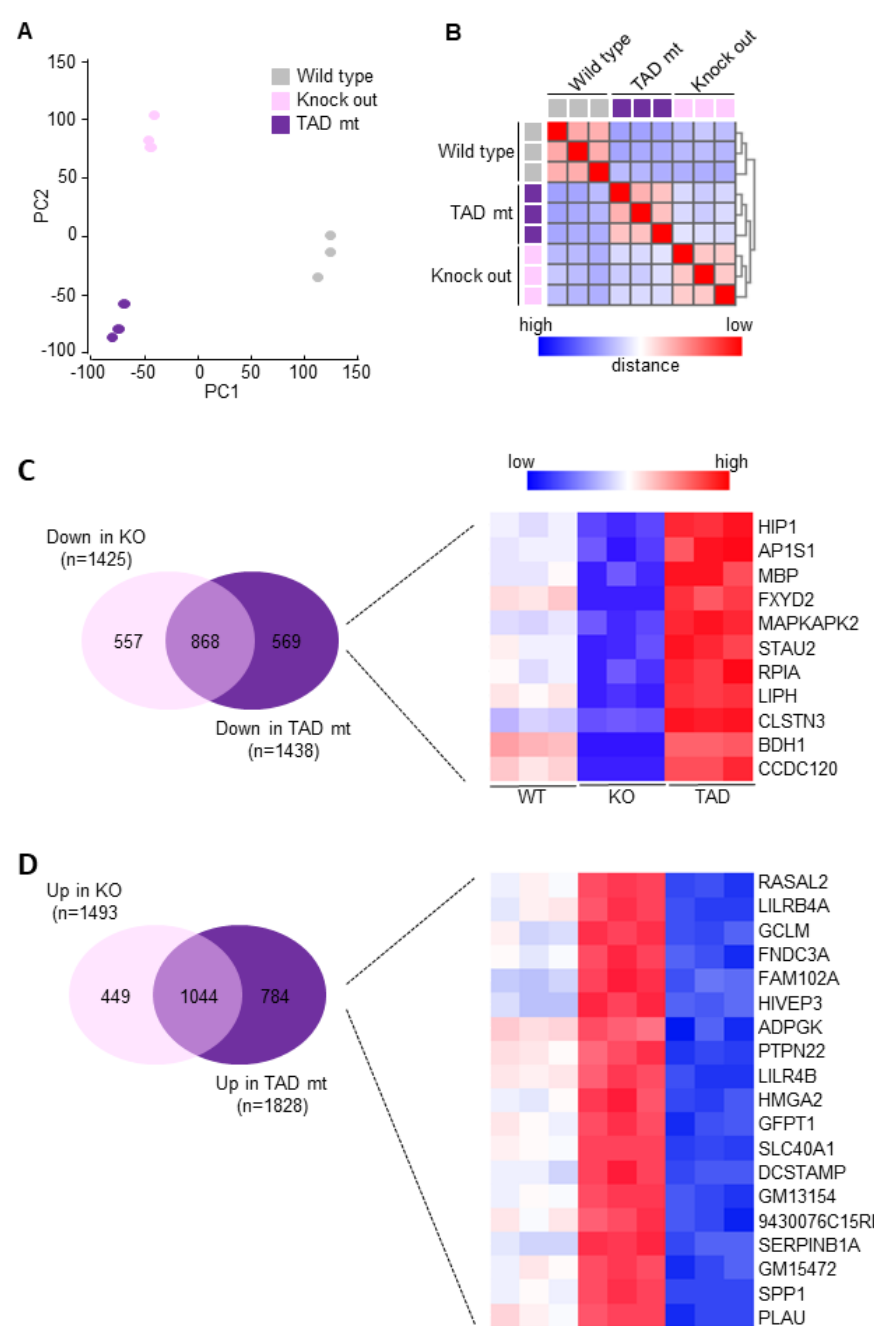
Figure 4. RNAseq gene expression analysis of wild-type (WT), C/EBP δ knock-out (KO) and C/EBP δ mutant ( ∆ TAD) macrophages. ( A ) Principal component analysis of pairwise genetic distances be- tween the different macrophage subtypes. ( B ) Correlation heat map showing the Euclidean distances between the different macrophage subtypes. ( C ) Venn diagram showing overlap in downregulation of genes in knock-out and ∆ TAD macrophages with a heatmap of genes downregulated in knock- out macrophages but upregulated in ∆ TAD macrophages. ( D ) Venn diagram showing overlap in upregulation of genes in knock-out and ∆ TAD macrophages with a heatmap of genes upregulated in knock-out macrophages but downregulated in ∆ TAD macrophages. Heatmaps were generated using heatmapper (http://www.heatmapper.ca [39] assessed on 24 November